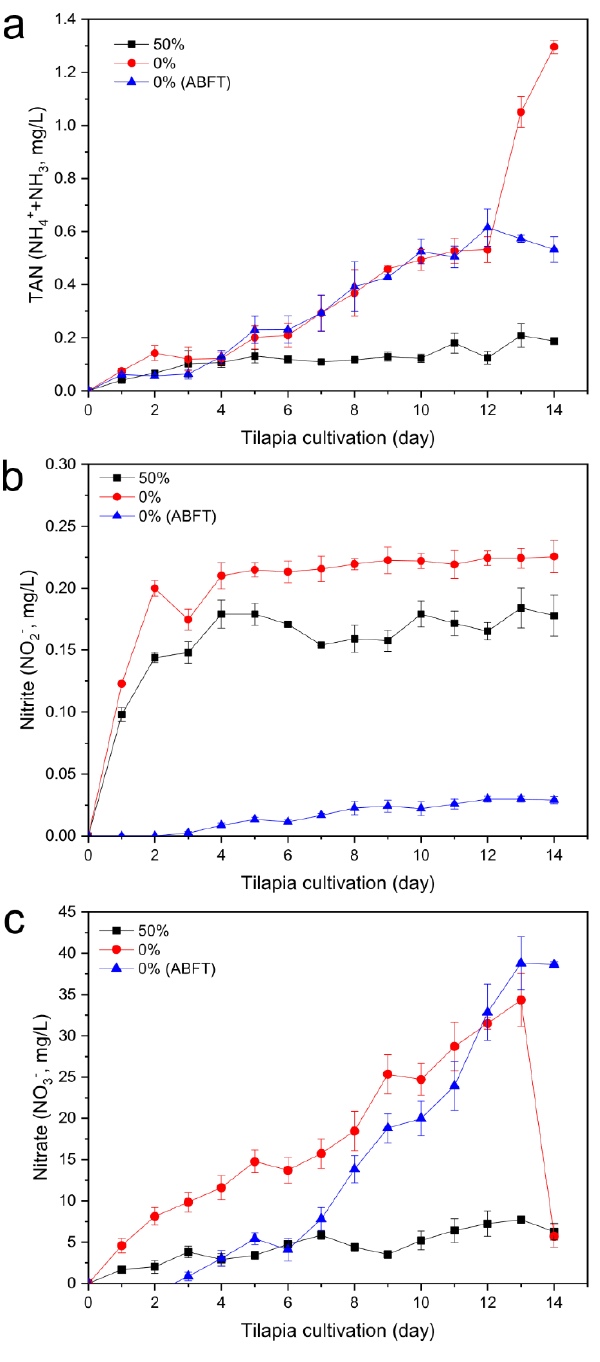
Figure 1. Nutrient-removal efficacy: (a) TAN (NH 4+ and NH 3 ), (b) Nitrite (NO 2− ) and (c) Nitrate (NO 3− ). Groups: 50% (closed squares; water replacement daily); 0% (closed circles; no water replacement); ABFT (closed triangles; no water replacement; including Chlorella ellipsoidea and Scenedesmus dimorphus